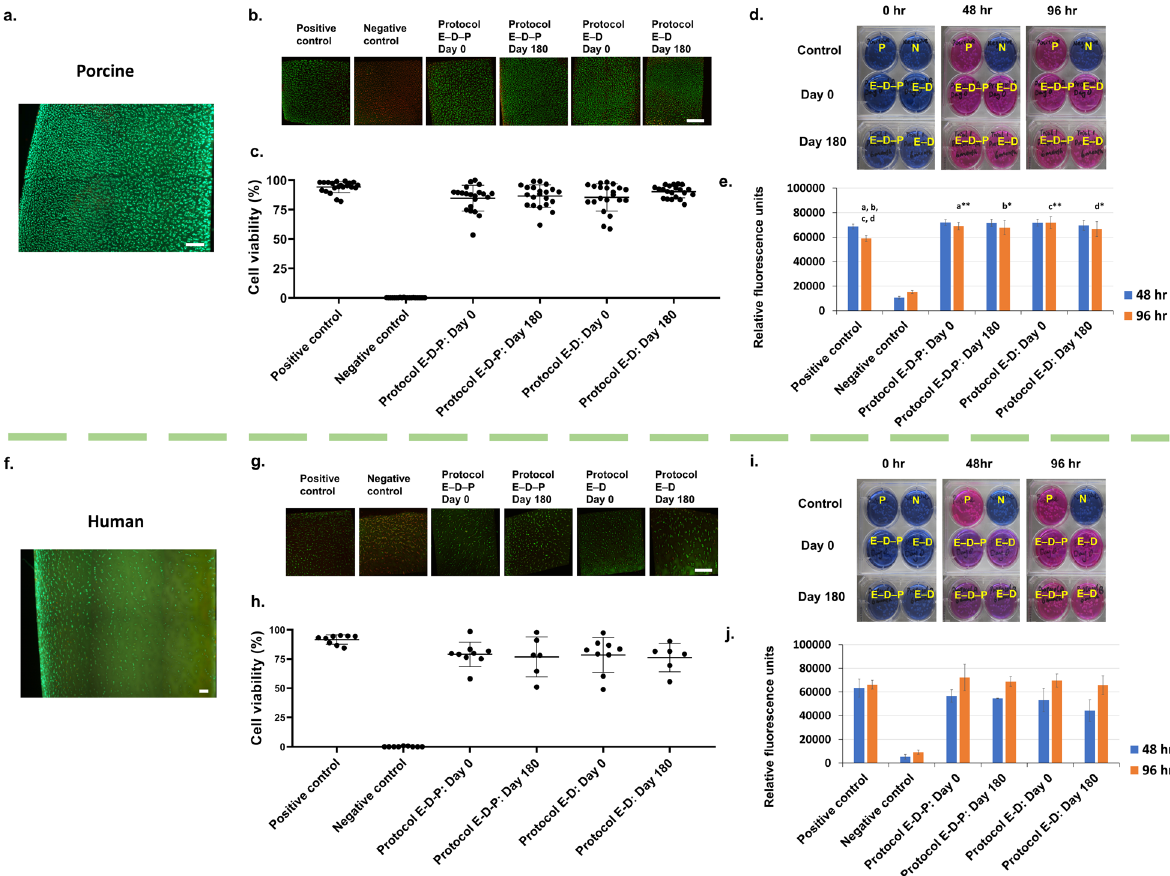
Fig. 3 Assessment of cell viability and metabolic function of chondrocytes in situ after vitri fi cation and subsequent rewarming. a Representative image of healthy full-thickness porcine cartilage section. b Representative images of porcine cartilage samples showing live (green) and dead (red) chondrocytes by a cell membrane integrity stain using two fl uorescent dyes: Syto 13 and propidium iodide and imaged by a laser scanning confocal microscope (×100 magni fi cation). c Quanti fi cation of porcine chondrocyte viability of the positive control, negative control, Protocol E – D – P at day 0, Protocol E – D – P at day 180, Protocol E – D at day 0, and Protocol E – D at day 180 ( n = 21 replicates per group: no statistical differences between the protocols and the storage times, p = 0.261, two-way ANOVA). d Representative images of the alamarBlue assay showing porcine chondrocyte metabolic activity from particulated articular cartilage in positive (P) and negative (N) controls and after vitri fi cation at 0, 48, and 96 h. e Quanti fi cation of porcine chondrocyte metabolic activity ( n = 7 replicates per group: signi fi cant rebound of chondrocyte metabolic activity at 96 h in the experimental groups compared to the positive control, p a = 0.003; p b = 0.011; p c < 0.001; p d = 0.035, two-way ANOVA and Tukey ’ s test). f Representative image of healthy full-thickness human cartilage section. g Representative images of human cartilage samples showing live (green) and dead (red) chondrocytes by a cell membrane integrity stain using two fl uorescent dyes: Syto 13 and propidium iodide and imaged by a laser scanning confocal microscope (×100 magni fi cation). h Quanti fi cation of human chondrocyte viability of the positive control, negative control, Protocol E – D – P at day 0, Protocol E – D – P at day